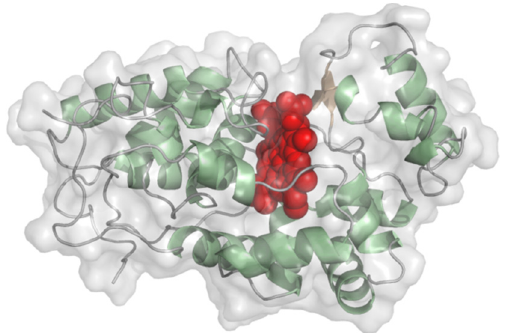
Figure 3. Crystal structure of Armoracia rusticana peroxidase (PDB: 1ATJ) with its heme cofactor (red spheres) almost protruding from the protein surface.